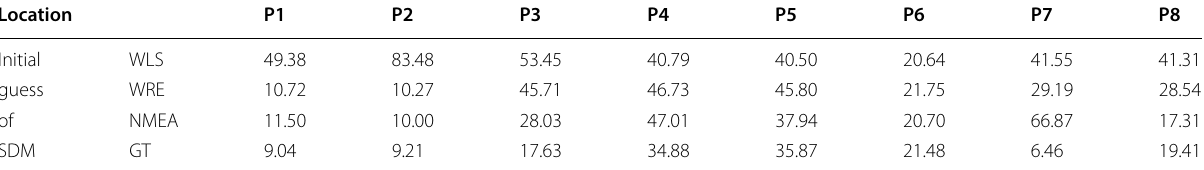
Table 7 The mean error of SVM classification based shadow matching initialized by different approaches (m) Location